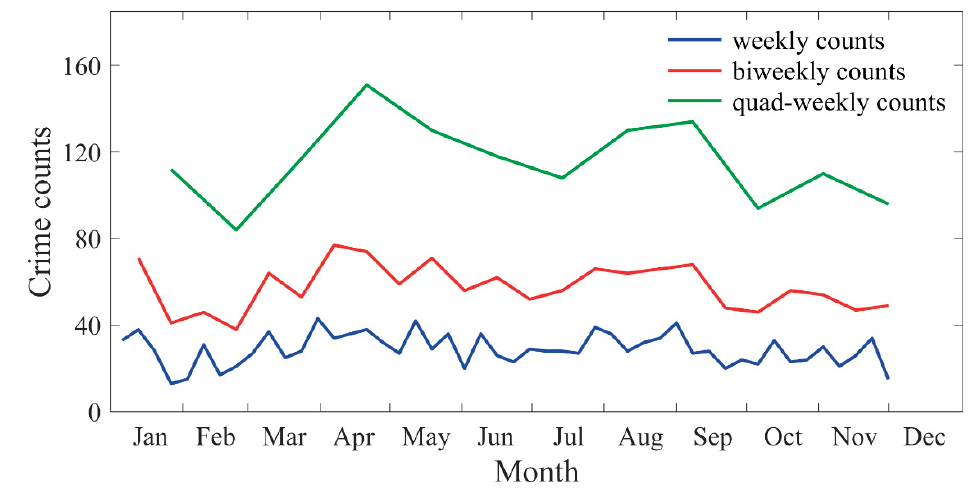
Figure 1. The temporal distribution of weekly, biweekly, and quad-weekly crime counts in the XT police district (2 January 2017 to 3 December 2017).